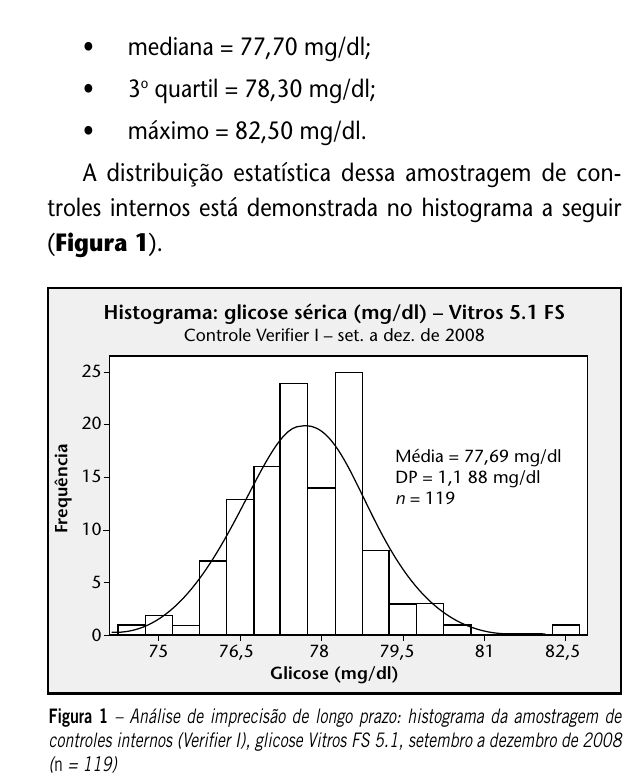
Glicose: gráfico de controle de Levey-Jennings OCD Vitros FS 5.1 – Controle Verifier I – set. a dez. de 2008 Dados CQ Diário * Limites de controle definidos utilizando os primeiros 20 resultados CQ (média = 77,415; DP = 1,12)